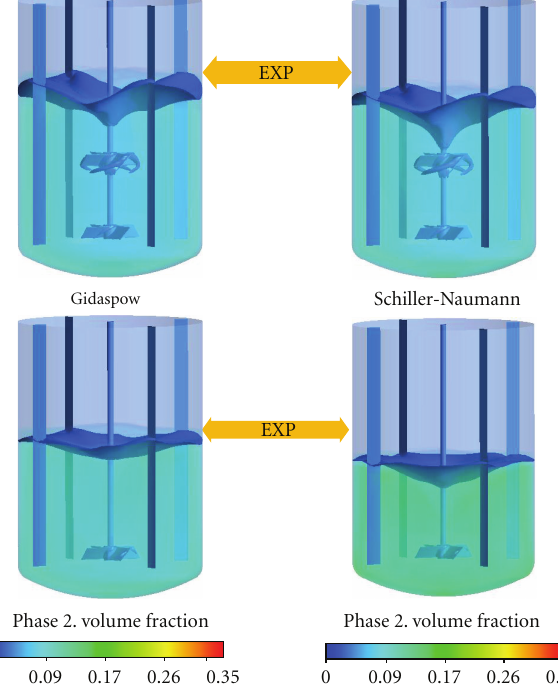
Figure 6: E ff ect of drag model. Volume rendered plots with isosurface for single- and dual-impeller configurations, 15% (w/w) loading, 300RPM. The double-headed arrows marked “EXP” represent the location of experimental observation with arrow thickness representing the observed 8% spread in the experimental data.